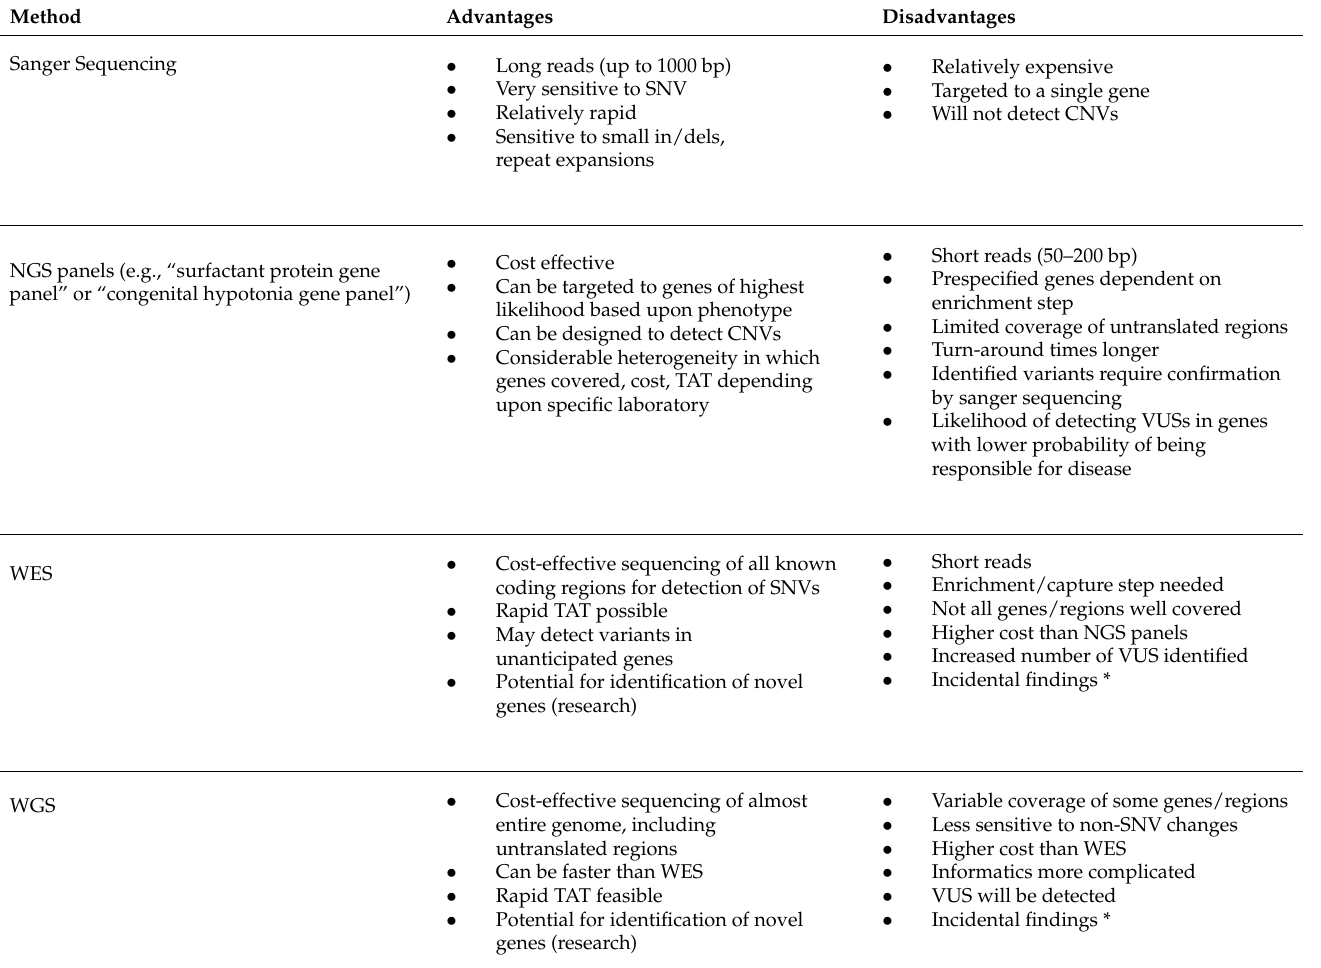
Table 4. Advantages and disadvantages of different genetic sequencing